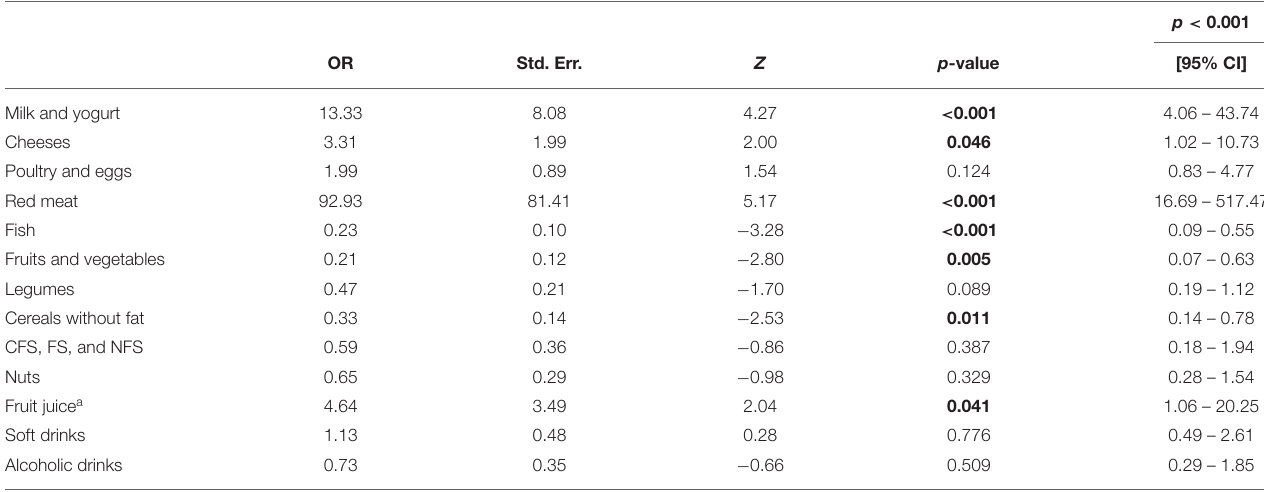
TABLE 8 | Logistic regression analysis reporting odds ratios of water expenditure risk regarding average healthy diet water footprint (WF) and adherence to Mexican dietary recommendations.